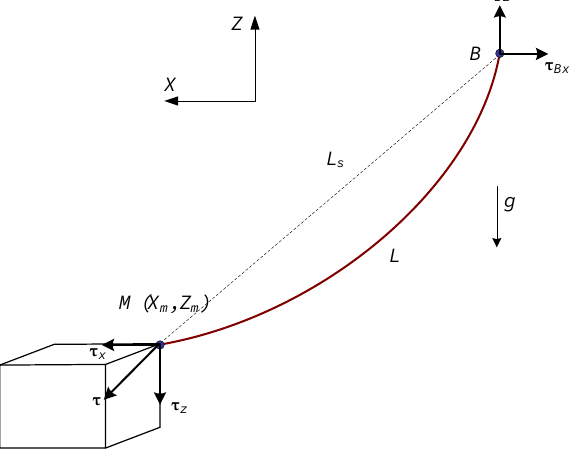
Figure 6. The sag of the cable between two points.